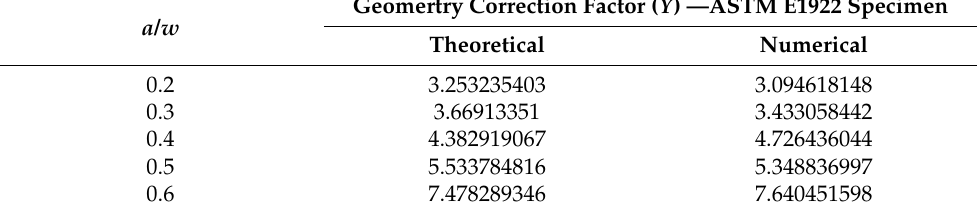
Table 8. Comparison between the theoretical and numerical results of Y for TTC ASTM E1922 specimen.